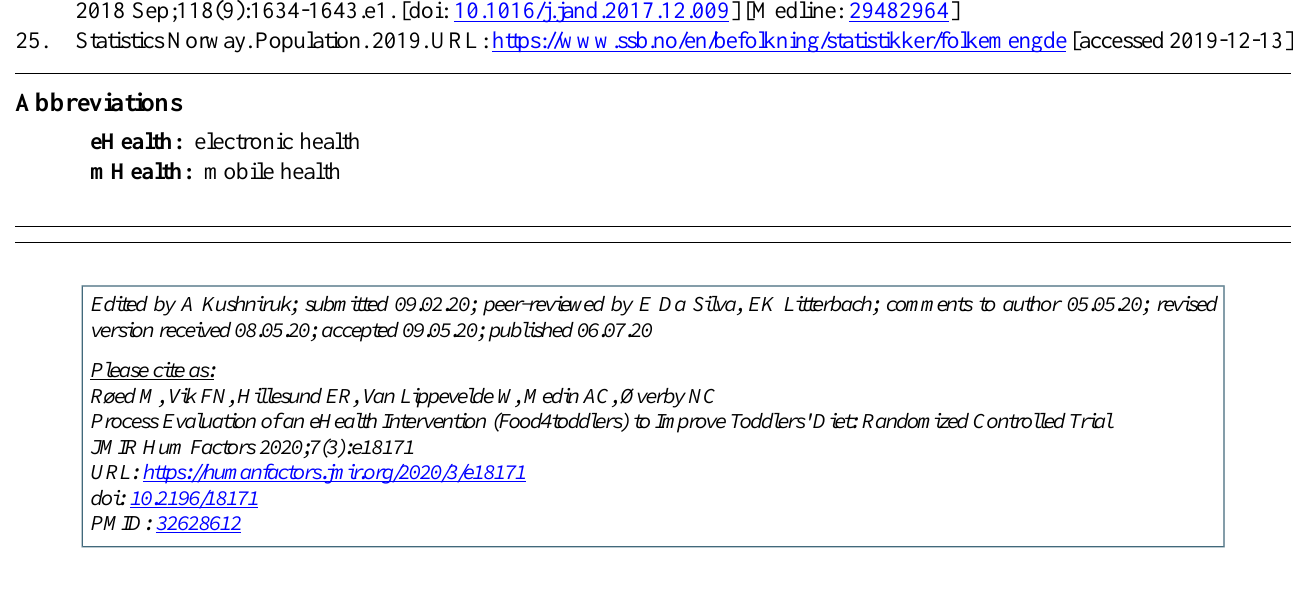
Cecilie Øverby. Originally published in JMIR Human Factors (http://humanfactors.jmir.org), 06.07.2020. This is an open-access article distributed under the terms of the Creative Commons Attribution License (https://creativecommons.org/licenses/by/4.0/), which permits unrestricted use, distribution, and reproduction in any medium, provided the original work, first published in JMIR Human Factors, is properly cited. The complete bibliographic information, a link to the original publication on http://humanfactors.jmir.org, as well as this copyright and license information must be